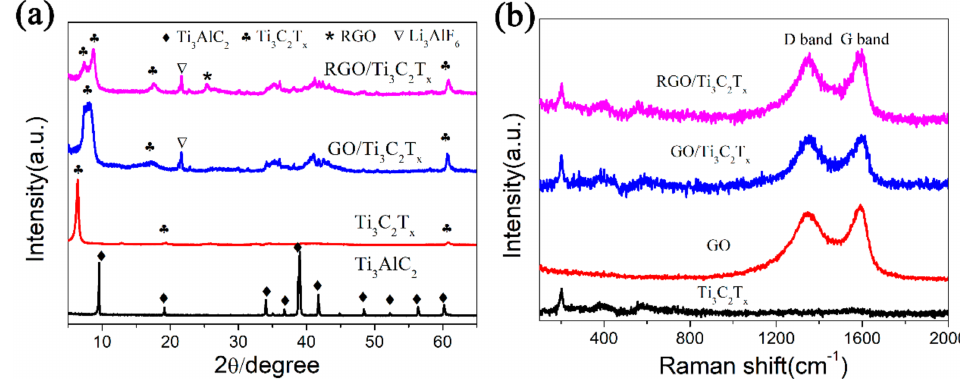
Figure 1. ( a ) X-ray diffraction (XRD) patterns and ( b ) Raman spectrum of Ti 3 AlC 2 , Ti 3 C 2 T x ,